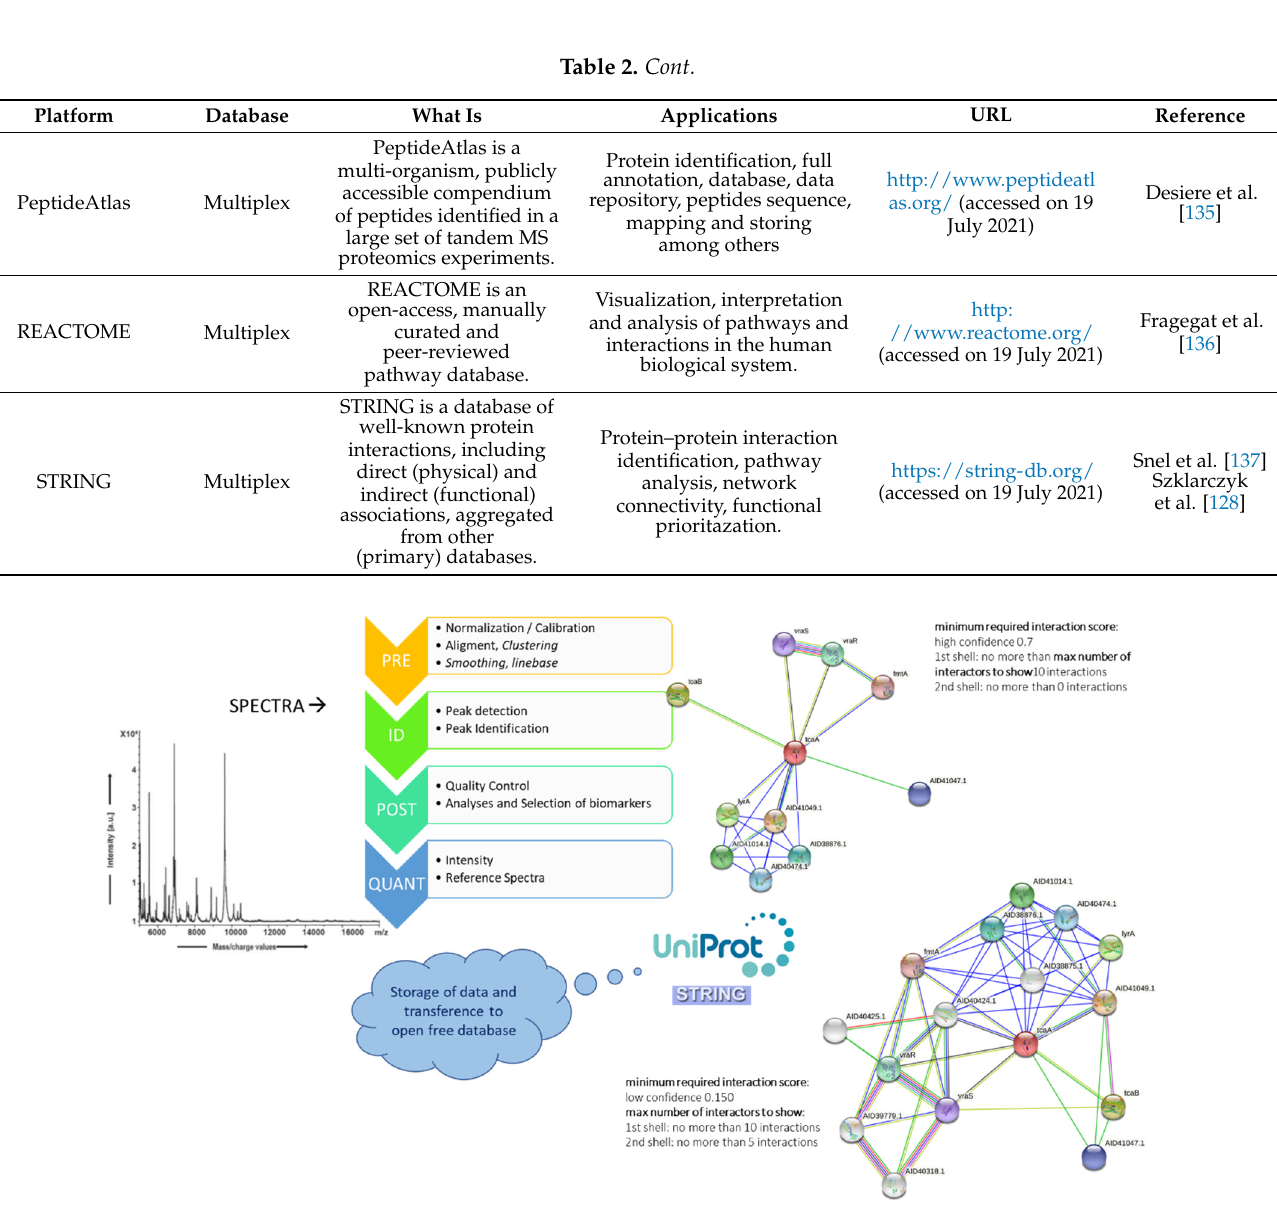
Figure 4. A possible computational workflow for data analysis from MALDI–TOF MS using the STRING database. Example of a network of interactions for the TcaA protein involved in Staphylococcus aureus resistance to glycopeptides using STRING. The membrane-associated protein is co-expressed upstream with the peripheral membrane protein FmtA which affects the methicillin resistance. TcaAB is responsible for susceptibility to glycopeptides, especially teicoplanin, in S. aureus [138,139]. The dysfunction or absence of either of these two proteins TcaAB is associated with resistance to glycopeptides and is subject to regulation by the two-component system VraSR (S: sensor, R: regulator) [138,140].